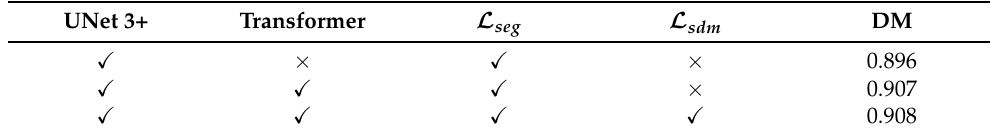
Table 2. Ablation experiments of the model on the MICCAI 2018 test set. UNet